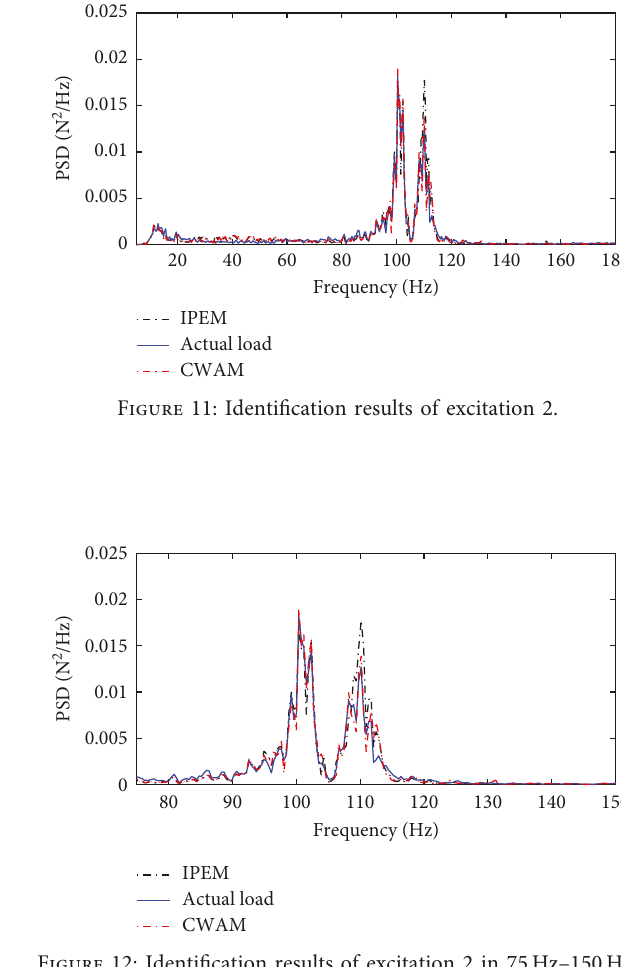
Figure 12: Identification results of excitation 2 in